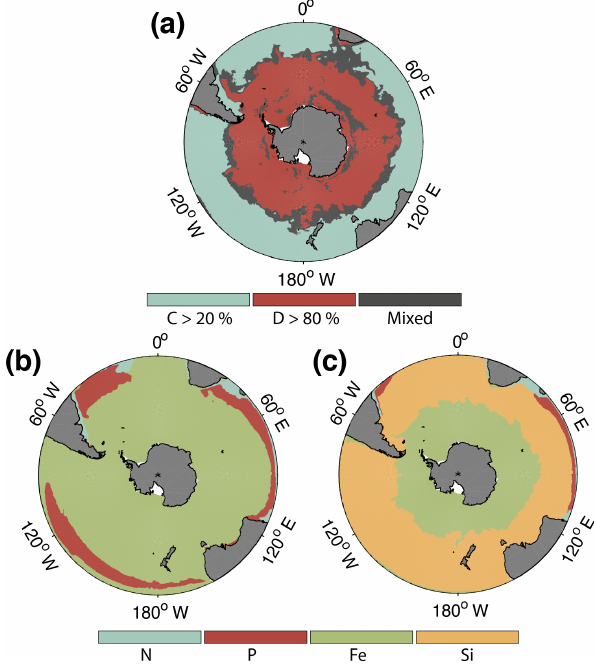
Figure 2. (a) Spatial distribution of phytoplankton communi- ties in ROMS–BEC: diatom-dominated phytoplankton community vs. mixed communities with substantial contributions of coccol- ithophores and small phytoplankton. Communities in which nei- ther coccolithophores (c) nor diatoms (d) contribute > 20% and (blue) > 80% (red), respectively, to total annual NPP are classified as mixed communities (grey). (b–c) Annual mean most limiting nu- trient for (b) coccolithophore and (c) diatom growth rates at the sur- face. For small phytoplankton, the nutrient limitation pattern south of 40 ◦ S is generally the same as for coccolithophores (not